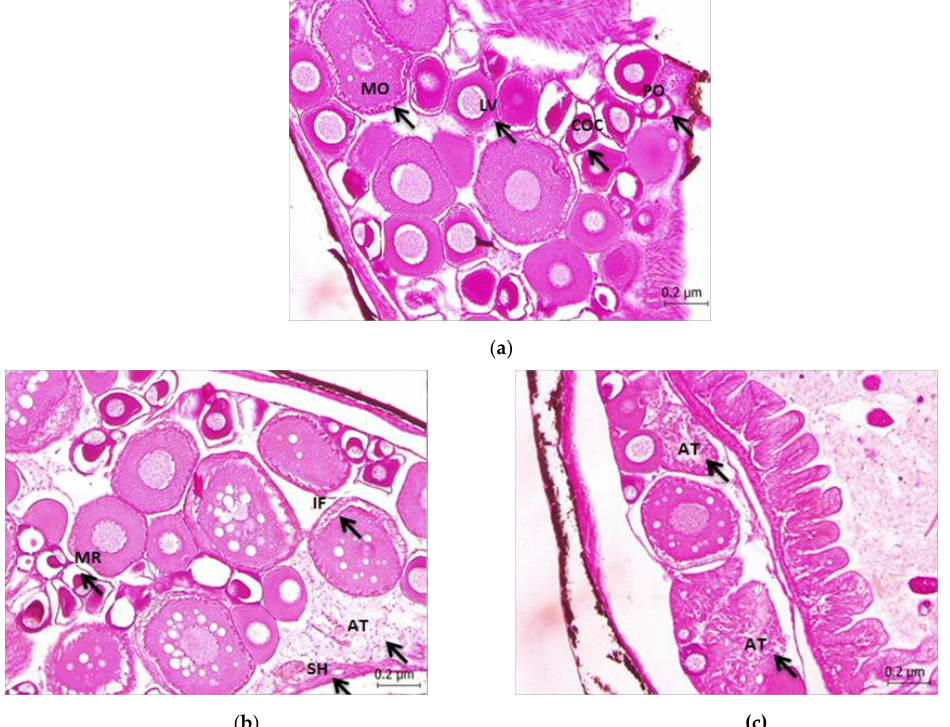
Figure 1. ( a ) Micrographs of dechlorinated water control treatment of Javanese medaka’s ovary section (5 µ m) stained with H and E × 400. PO-Perinucleolar Oocytes, COC-Cortical Alveolar Oocytes, LV- Late Vitellogenic Oocytes, MO- Mature Oocytes. ( b ) Micrographs of 50 µ g / L of Diuron chronic exposure of Javanese medaka’s gonad section (ovary) (5 µ m) stained with H and E × 400. Stromal hemorrhage (SH), atretic follicle visible within an ovary (AT), membrane retraction (MR), and Interstitial Fibrosis (IF). ( c ) Micrographs of 500 µ g / L of Diuron chronic exposure of Javanese medaka’s gonad section (ovary) (5 µ m) stained with H and E × 400. The ovary shows the increasing of the atretic follicle and decreasing of the follicular stage LV: Late Vitellogenic Oocytes; MO: Mature Oocytes.